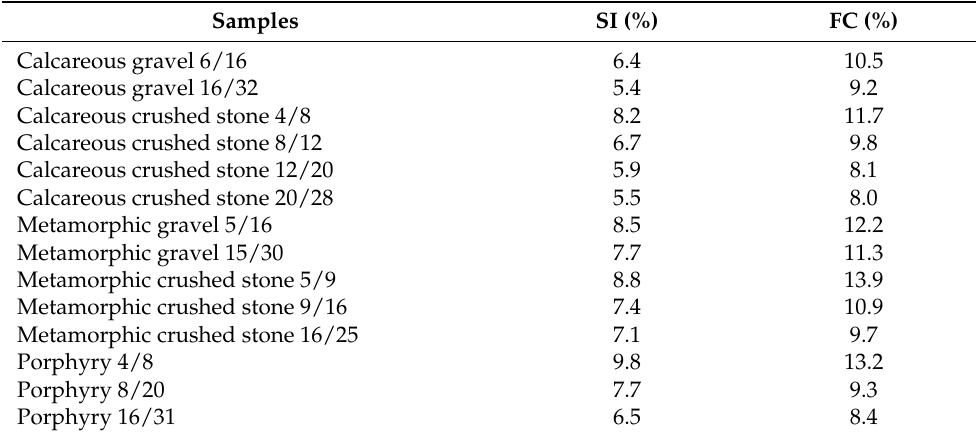
Table 8. Shape index (SI) and flattening coefficient (FC) of the samples analyzed and expressed in percentage [33].